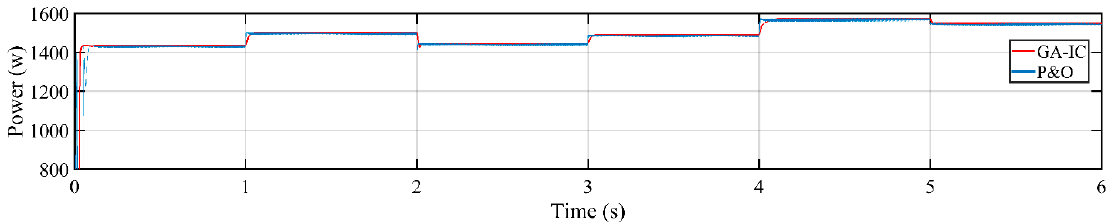
Figure 32. Case 3 power comparison of modified GA-IC vs. P&O.